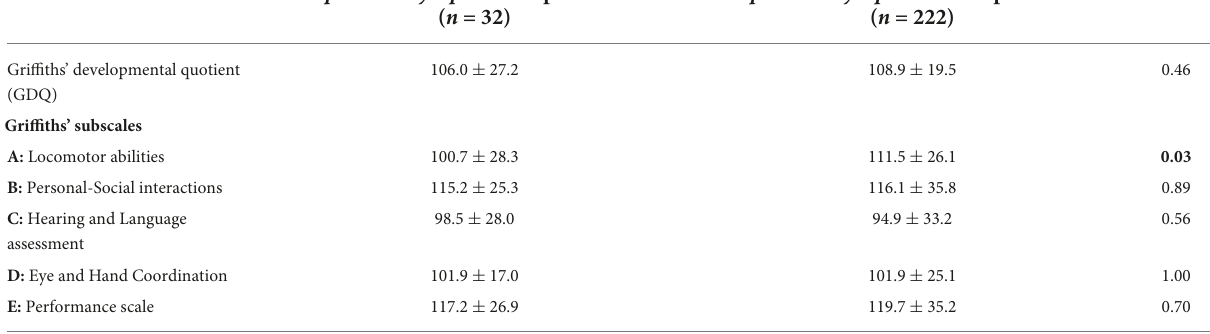
TABLE 3 Griffiths’ at 24 months CA in exposed and unexposed infants to U./M . colonization during pregnancy. Ureaplasma/Mycoplasma exposed infants Ureaplasma/Mycoplasma unexposed infants P ( n = 32) ( n = 222)